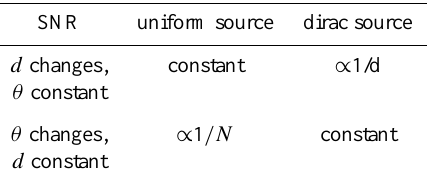
Table 1. Evolution of the SNR when the distance d to the objective changes, and when the angular resolution θ increases by a factor N , for a uniform source, and a dirac-like